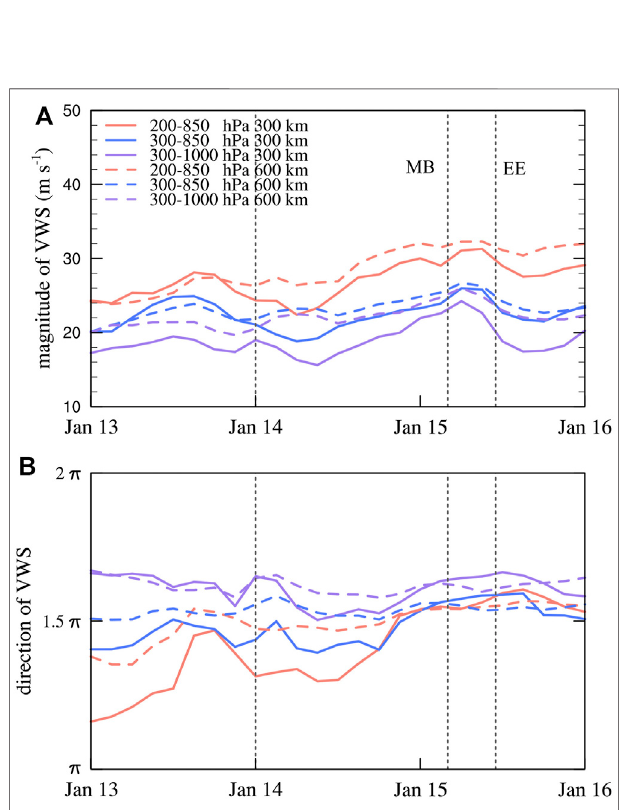
FIGURE7| Time seriesofaveragedeeplayer verticalwind shear over a circular area within the radii of 300 and 600 km (dashed) every 3 h from 0000 UTC on January 13 to 0000 UTC on January 16. (A) Magnitude of vertical wind shear and (B) direction of vertical wind shear ( π for south, 1.5 π for west, 2 π for north). The three dashed lines are the same as in Figure 4 .